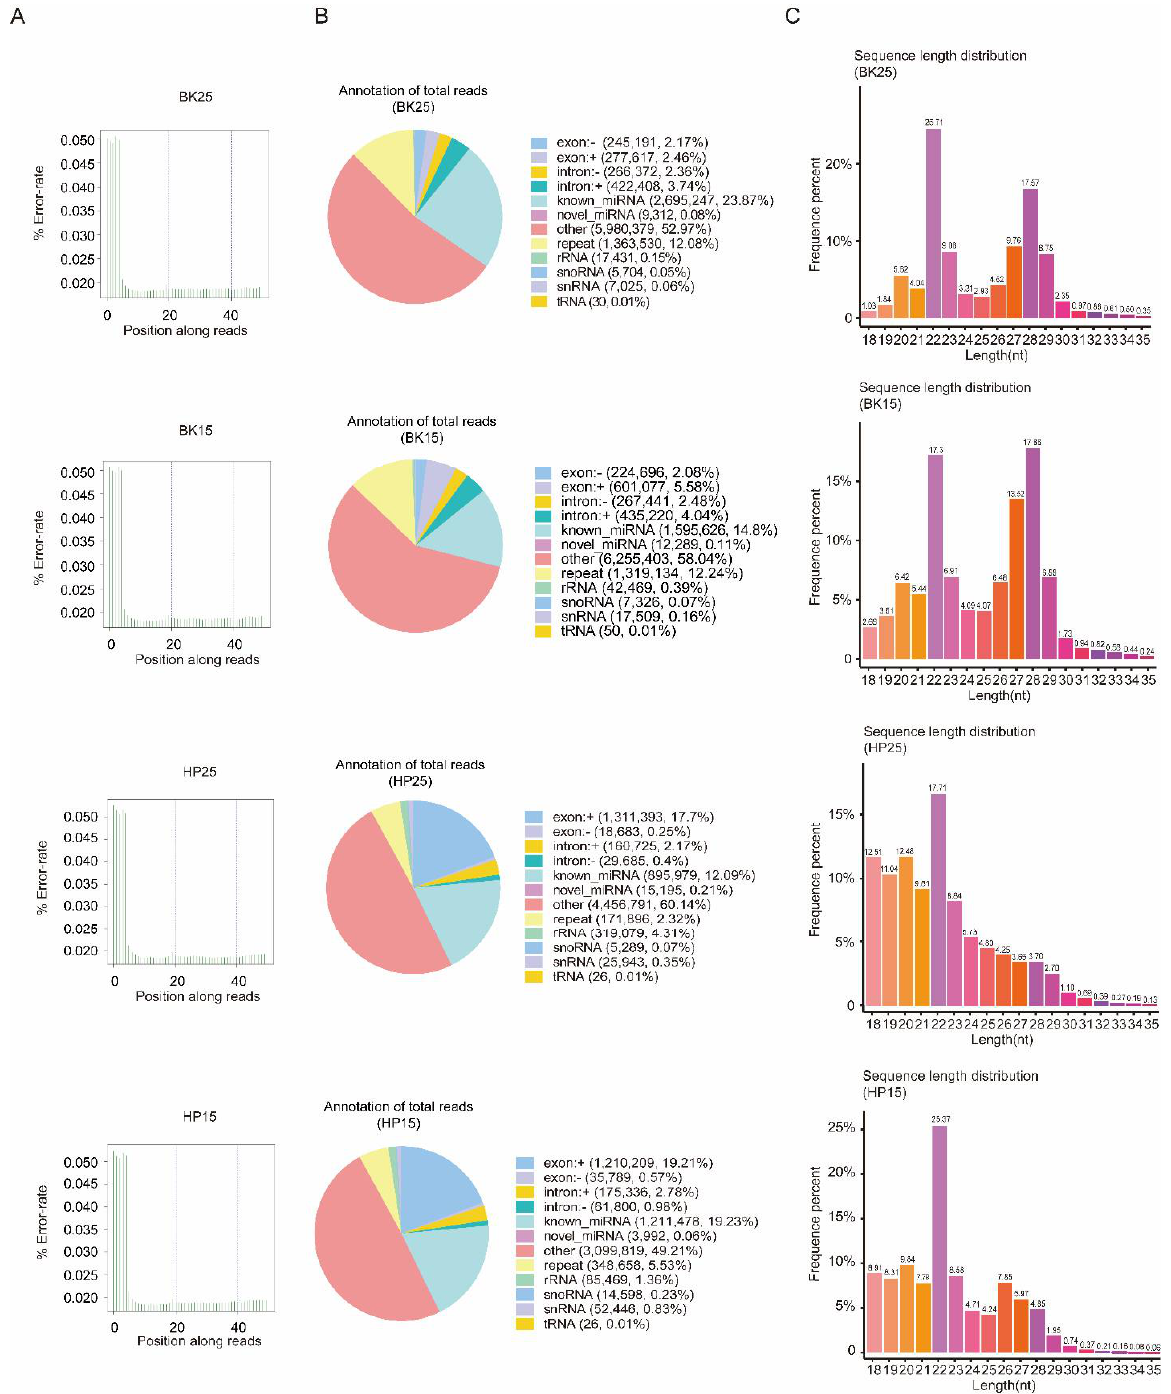
Figure 1. Quality control of sequencing data and distribution of non-coding RNA (ncRNA). ( A ) The distribution of sequencing error rate in BK25, BK15, HP25, and HP15. Owing to the incomplete match between the random primer and the RNA template, the sequencing error rate of the first few bases reached about 0.05. For convenience, “BK25” and “BK15” represent the embryos incubated at 25 and 15 °C during the blastokinesis phase, respectively; “HP25” and “HP15” represent the embryos incubated at 25 and 15 °C, respectively, during the head pigmentation phase. ( B ) Distribution of ncRNA in BK25, BK15, HP25, and HP15. ( C ) Length distribution of sRNA in BK25, BK15, HP25, and HP15. nt, nucleotide.